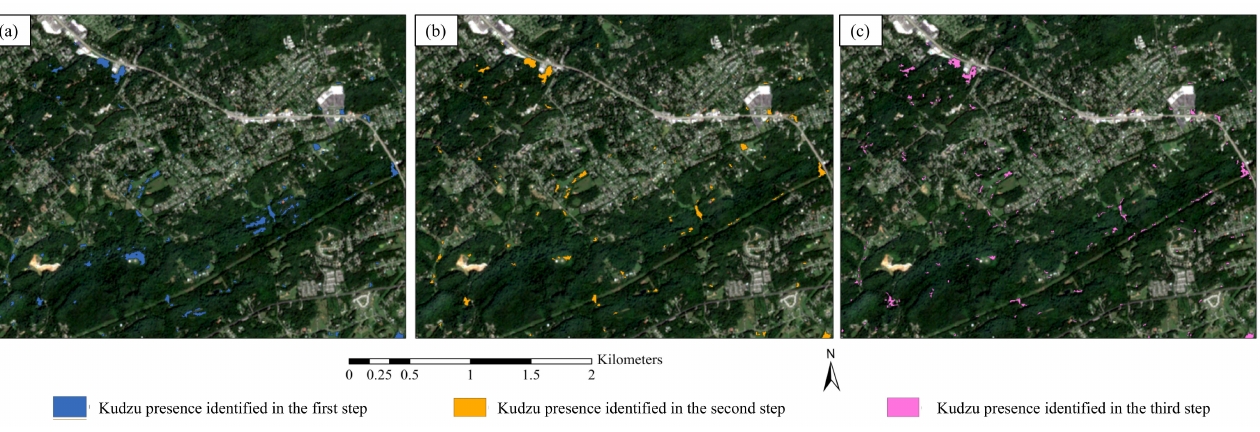
Figure 8. Kudzu abundance maps in Knox County: ( a ) initial kudzu abundance map from linear unmixing (step 1); ( b ) refined kudzu abundance map of the extracted areas from nonlinear unmixing (step 3). Specifically, areas with kudzu abundance ≤ 0.6 are displayed in green and areas with kudzu abundance > 0.6 are displayed in yellow to red.